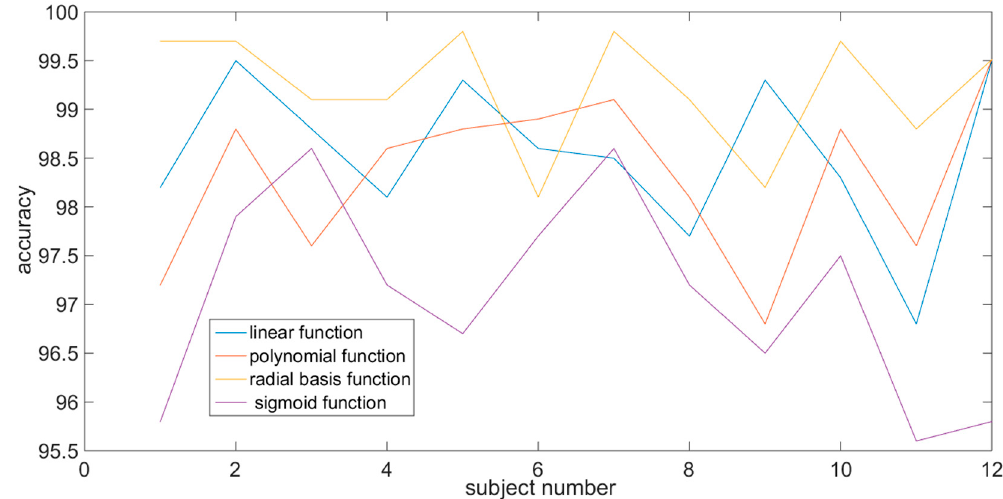
Figure 6. The classification accuracies with four different kernel functions.